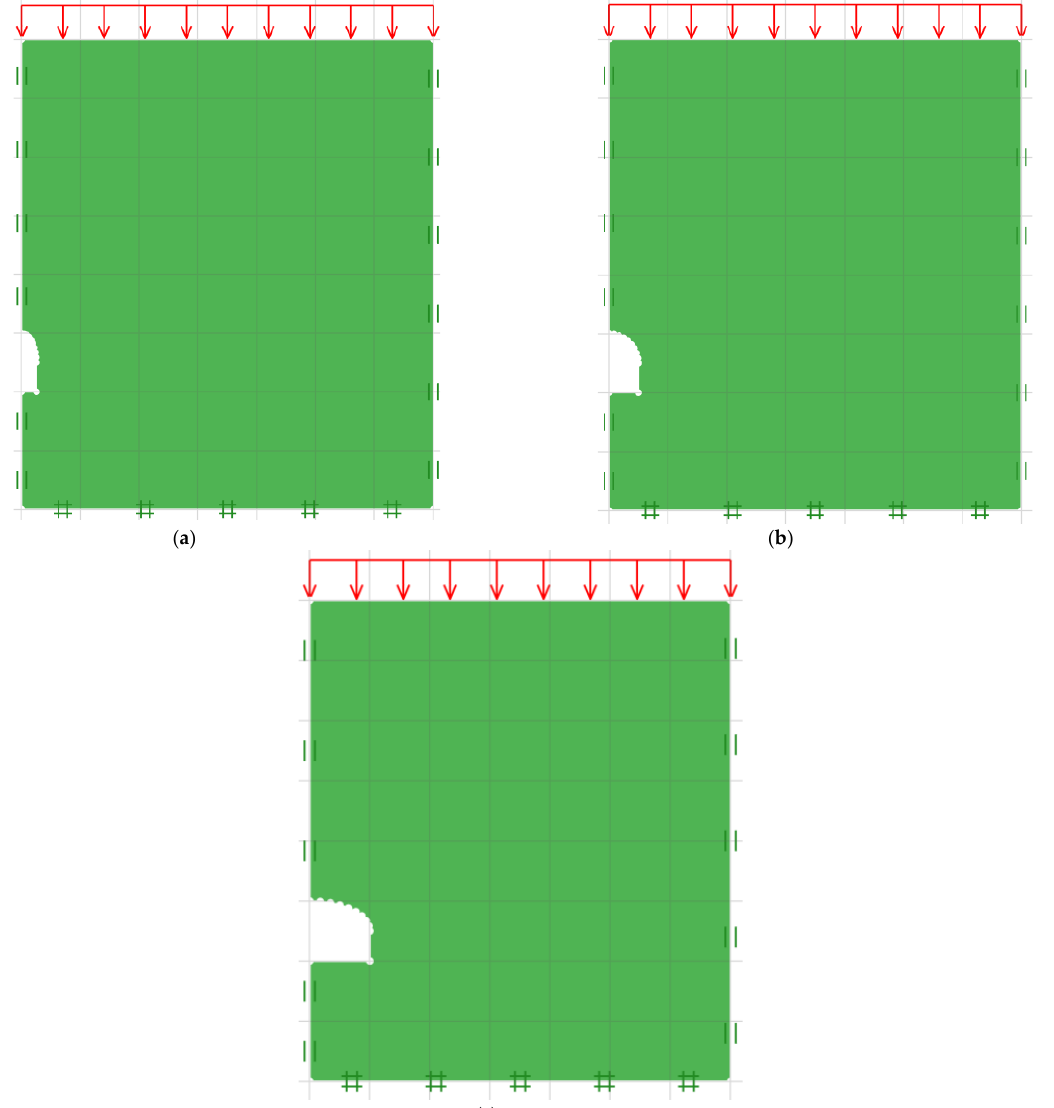
Figure 2. Numerical model used for FELA analysis of unlined horseshoe tunnel in Cohesive-frictional soil: ( a ) B/D = 0.5, ( b ) B/D = 1 and ( c ) B/D = 2.